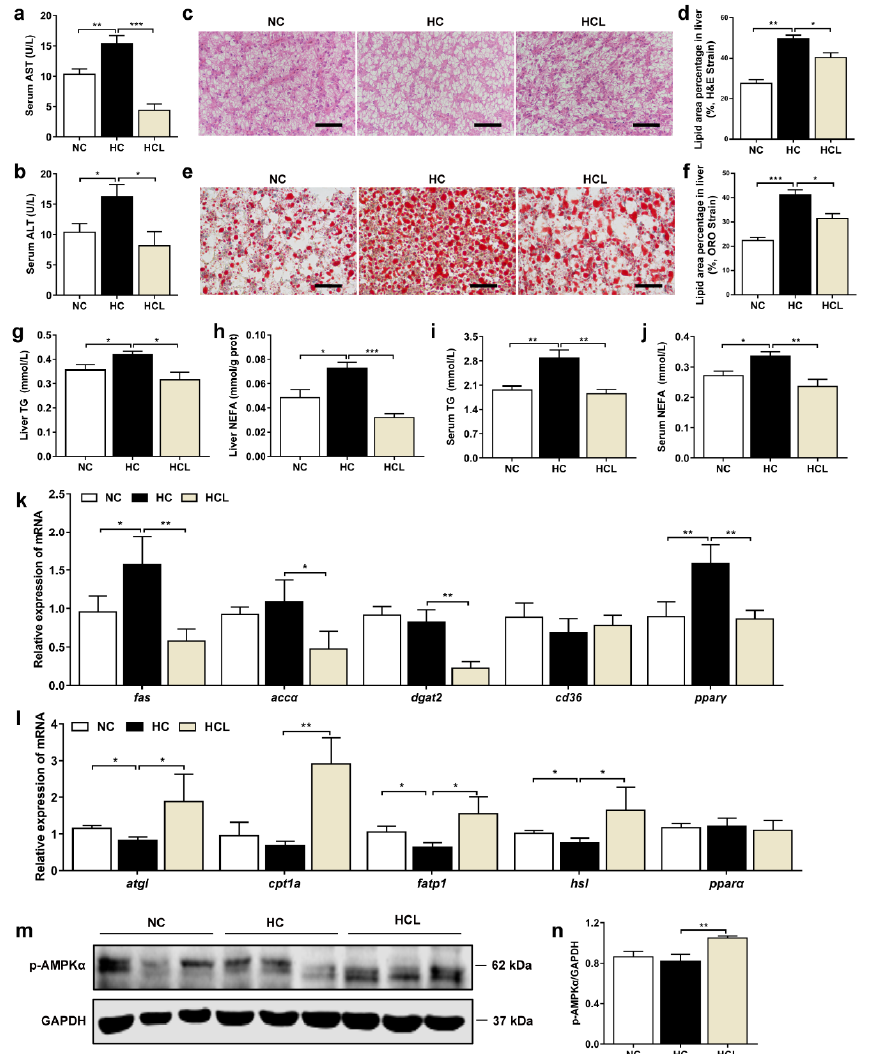
Figure 1. L. plantarum MR1 improved liver health in Nile tilapia fed with high-carbohydrate diet. ( a , b ) Serum contents of aspartate aminotransferase (AST) ( a ) and alanine aminotransferase (ALT) ( b ) ( n = 6). ( c – f ) Examination of the liver condition by hematoxylin and eosin (H&E) staining ( c , d ) and oil red O (ORO) staining ( e , f ). Scale bar, 50 μ m ( n = 3 slices). ( g – j ) Detection of the liver and serum triglyceride (TG) and non-esterified free fatty acid (NEFA) levels ( n = 6). ( k ) Relative expres- sion of lipid synthesis genes in the liver ( n = 6). ( l ) Relative expression of lipid catabolism genes in the liver ( n = 6). ( m ) Protein level of phosphorylated-AMP-activated protein kinase alpha (p- AMPK α ) energy homeostasis regulator in the liver ( n = 3). ( n ) The protein level of p-AMPK α was quantified and normalized to the loading control (GAPDH) ( n = 3). Statistics were analyzed by one- way ANOVA with Tukey’s adjustment and presented as mean ± SEM (*, p < 0.05; **, p < 0.01; ***, p < 0.001).